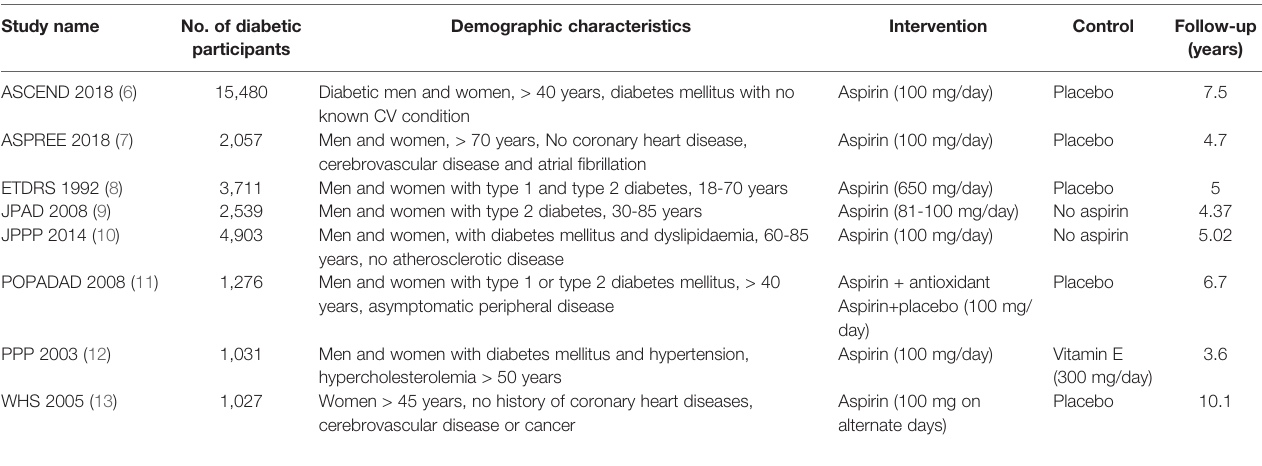
TABLE 1 | Characteristics of included